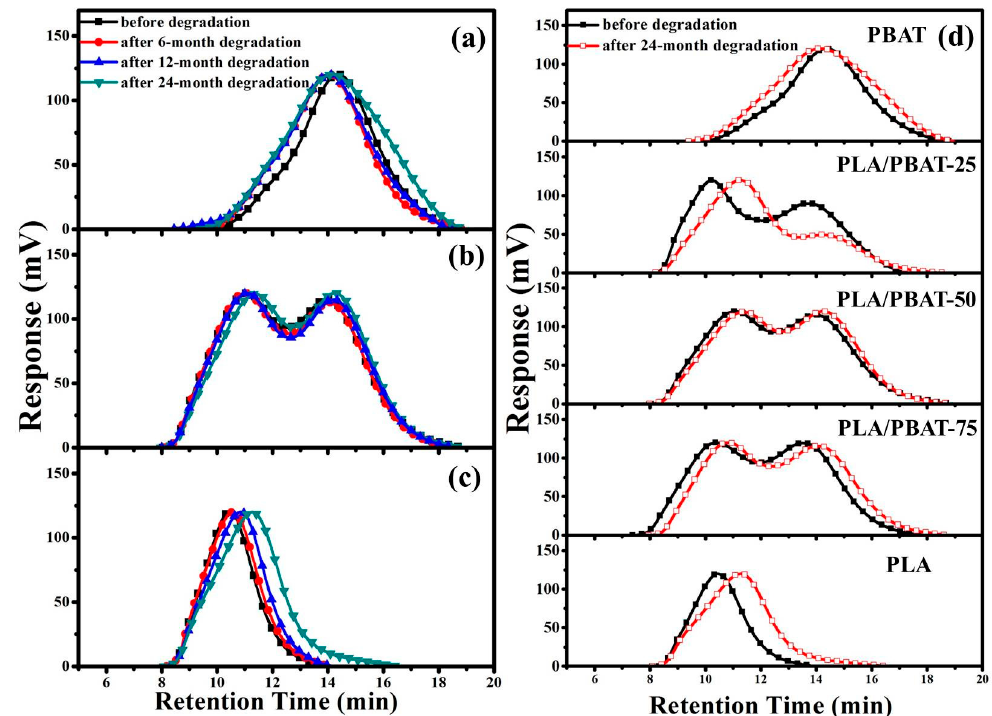
Figure 4. Gel permeation chromatography (GPC) curves of ( a ) PBAT, ( b ) PLA/PBAT-50, ( c ) PLA before and after degradation for different time, and ( d ) PLA/PBAT composite with different PLA content before and after 24 months of degradation.